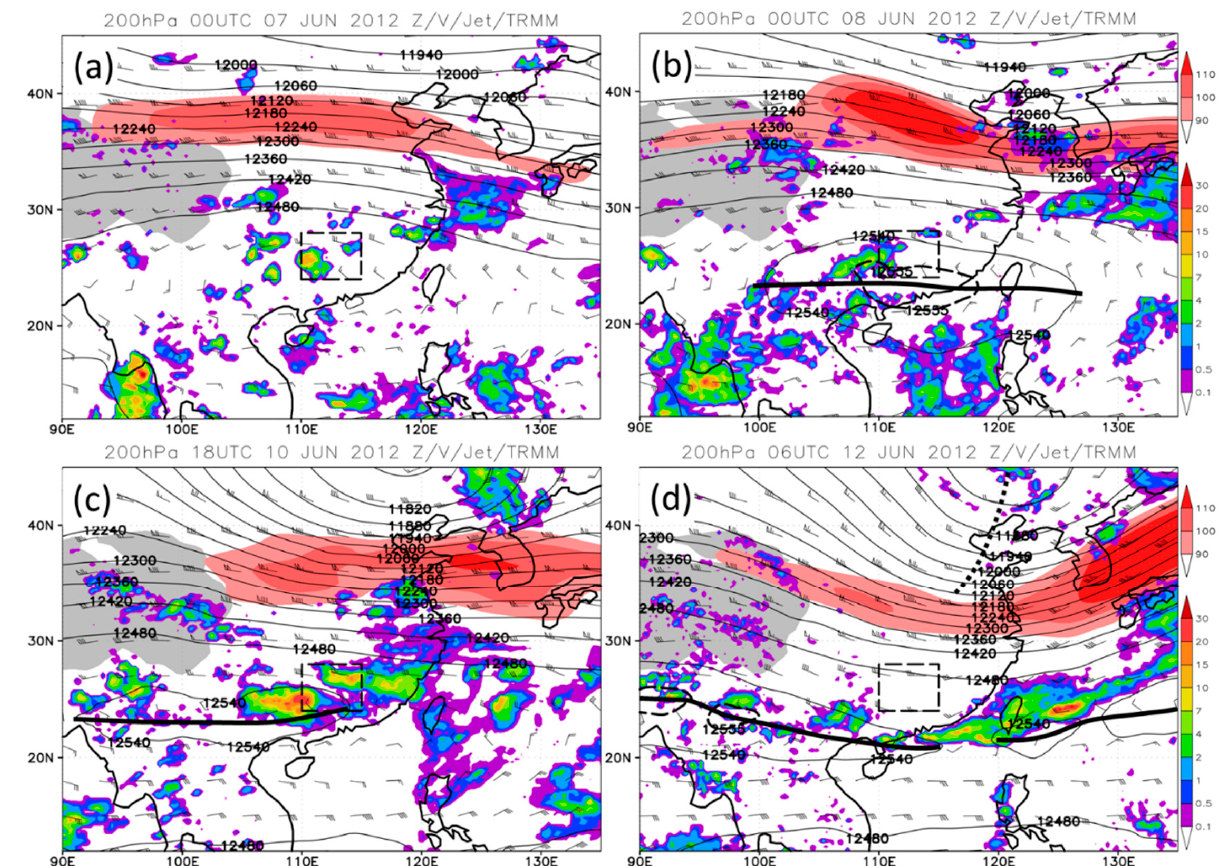
Figure 7. The geopotential height (gpm, contours, every 60 gpm), horizontal winds (barbs, full barb = 10 kt), and upper-level jet in excess of 90 kts (color, scale to upper right) at 200 hPa in the ERA-Interim analysis, overlaid with TRMM rainrate (mm h − 1 , color, scale to lower right) at ( a ) 0000 UTC 7, ( b ) 0000 UTC 8, ( c ) 1800 UTC 10, and ( d ) 0600 UTC 12 June 2012. The ridge (thick solid line) and trough (dotted line) are marked where needed. Gray shades indicate the topography higher than 3000 m, and the box for average in South China is also plotted (dashed box).